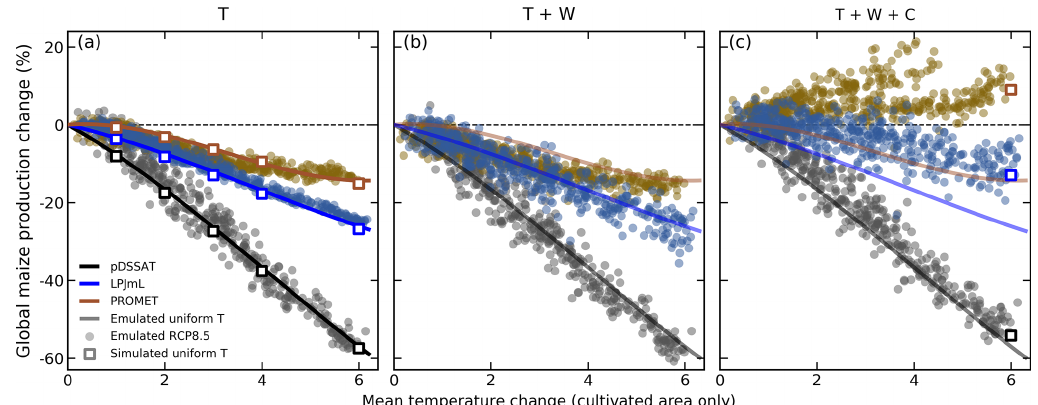
Figure 11. Illustration of the use of the emulator to study the factors affecting yields in a more realistic climate scenario. Figure shows emulated yield changes (relative to 1981–2010) for maize (both rainfed and irrigated) on currently cultivated land under RCP8.5 climate projections from three representative CMIP5 climate models (HadGEM2-ES, GFDL-ESM2M, and IPSL-CM5A-LR), using changes to T only (a) , to T and W (b) , and to T , W , and C ( c ). The x axis is the mean growing-season temperature change over cultivated land, computed using the historical growing season; note that these values will be higher than the corresponding global mean temperature change. Dots are emulated yearly global production changes to 2100 (90 years × 5 climate time series = 450 per crop model), with x axis the mean historical growing-season T shift over all grid cells where maize is grown (unweighted by within-cell cultivated area). (a) Using only temperature changes allows comparing regional simulated and emulated values. Open squares are GGCMI Phase 2 simulated values for each T level, with CWN held at baseline; bold lines are emulated values over uniform (cid:49)T shifts (repeated in each panel). Emulation uncertainty (compare squares to lines) is small relative to differences across climate and crop models, and mean yield changes are similar whether T changes are applied as a uniform shift or in a more realistic spatial pattern (compare lines to dots). (b) Adding in precipitation changes increases yield spread across climate projections and depresses yield slightly. No squares are shown in panel (b) because the GGCMI uniform offsets of both T and W are not directly comparable to GCM-specific changes of T and W in a climate projection. (c) CO 2 fertilization is small in pDSSAT, moderate in LPJmL, and very large in PROMET. The separation of groups of points in PROMET (gold) results because CMIP5 climate sensitivities differ by nearly a factor of 2; points at far right are under the highest-sensitivity model, HadGEM2-ES. In RCP8.5, the 30-year-average CO 2 at the end of the century is 807ppm (Riahi et al., 2011). For comparison, open squares in panel (c) show GGCMI-2 simulated production changes at T + 6, W = 0, C = 810ppm. (Note that in these climate projections, the mean CO 2 level when T > 5 . 8 ◦ is 912ppm.) See Figs. S14–15 in the Supplement for analogous figures for other crops (spring wheat and soybeans).